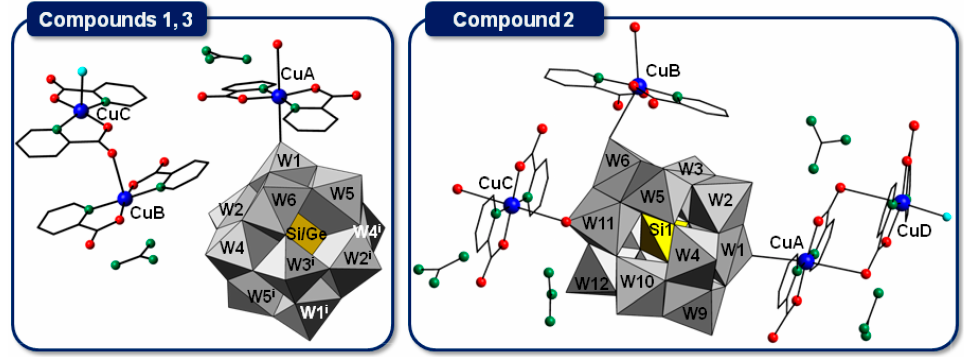
Figure 1. Connectivity between building blocks in the asymmetric units of 1 – 3 . Color code: W, gray polyhedra; Si/Ge, yellow polyhedra; Cu, blue spheres; N, green spheres; O, red spheres for O pic or O POM atoms and cyan spheres for terminal aqua ligands; C, black sticks. Symmetry code: (i) – x , – y , – z .